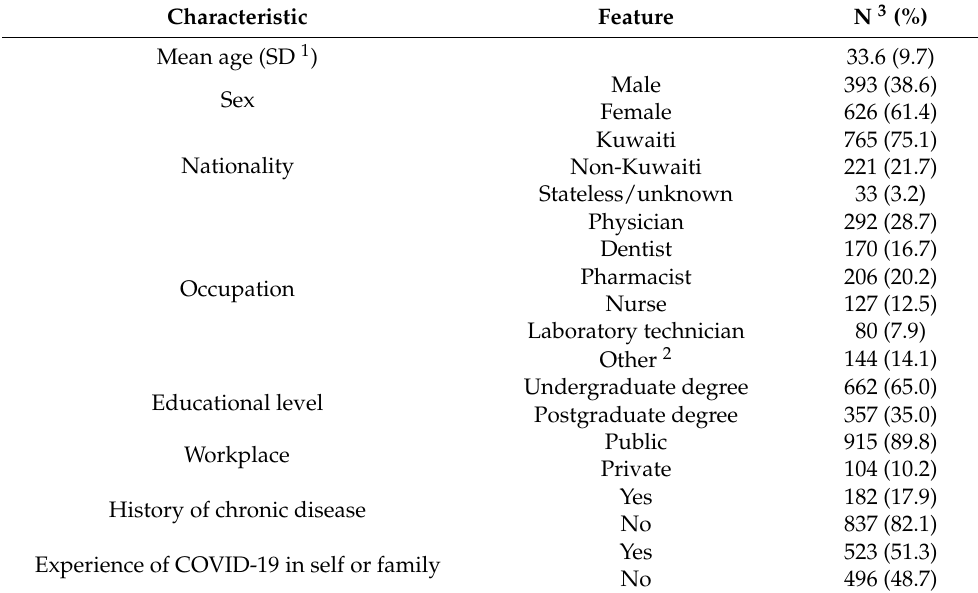
Table 1. The overall characteristics of the study participants.